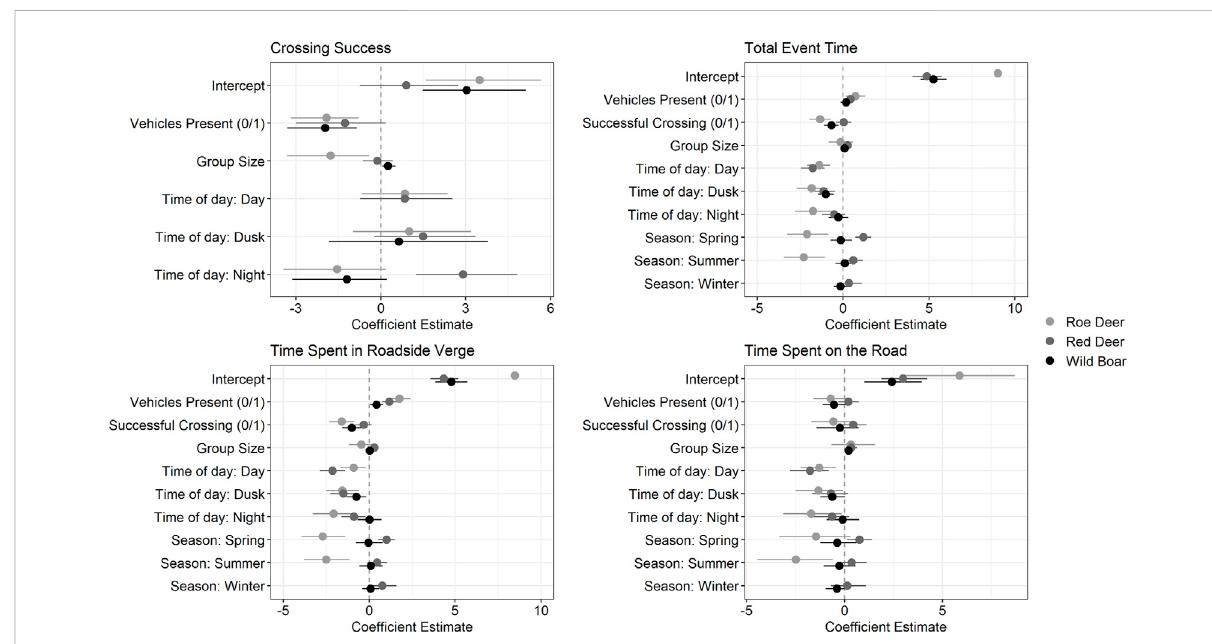
FIGURE 2 Coef fi cient plot of the four generalized linear models used in this study, to investigate crossing success, the time for a total event, the time animals spent in the roadside verge, and the time spent on the road. The points represent the beta estimates, and the error bars show the 95% con fi dence intervals. Those estimates that overlap 0 are deemed non-signi fi cant. Roe deer models are presented in light grey, red deer in dark grey, and wild boar in black. The reference categories were: Time of day: Dawn, and Season: autumn. Full model outputs are available in Table